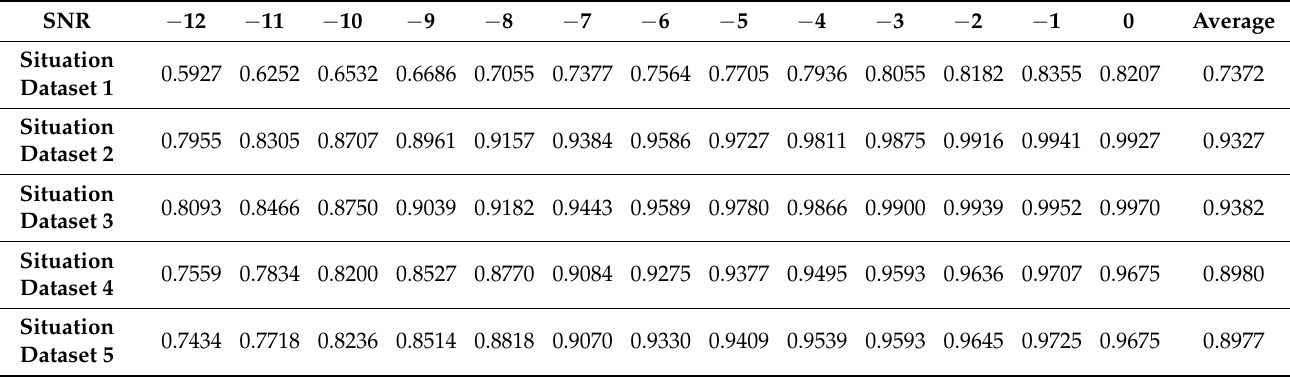
Table 11. The fully supervised classification accuracy for SNR with the datasets in Situation Dataset 1, Situation Dataset 2 and Situation Dataset 3 based on 1-D